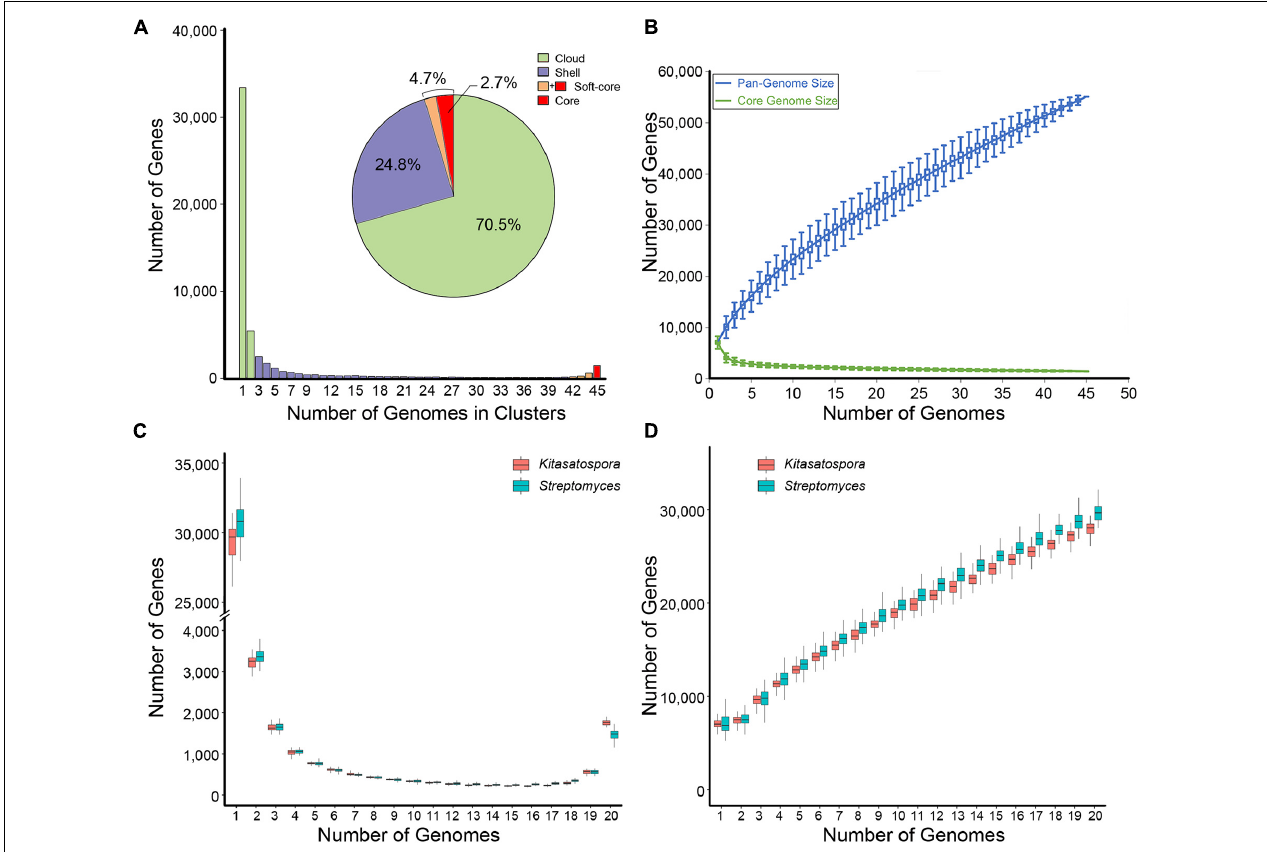
FIGURE 3 | Pan-genome profile of Kitasatospora . (A) Histogram distributions of cloud, shell, and (soft-) core genes. Pie chart displays percentage of each part of the total genes. (B) The sizes of pan- and core-genomes in relation to numbers of genomes added into the gene pool. (C,D) Comparison of the pangenome features between genera Kitasatospora and Streptomyces . The data was calculated from 50 subsets each containing 40 different species (pairwise ANI < 95%; 20 from Kitasatospora and 20 from Streptomyces ) randomly selected from the genome dataset. (C) Distribution of genes across strains. (D) The sizes of pan-genome in relation to numbers of genomes added into the gene